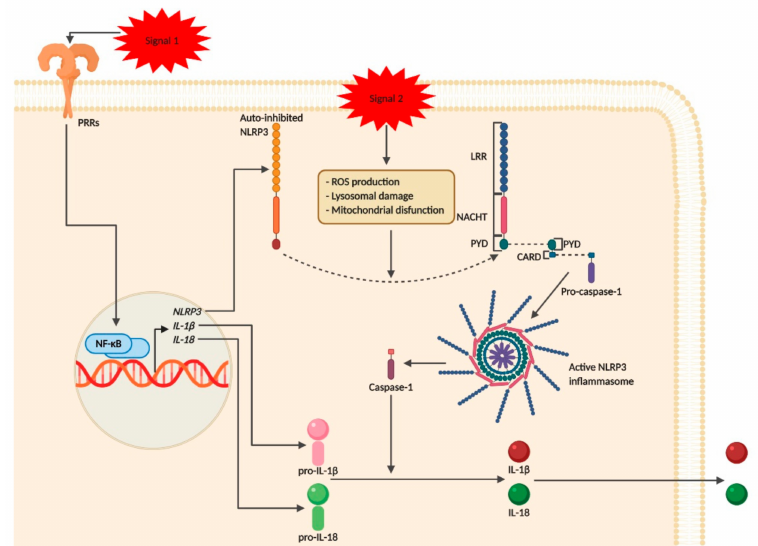
Figure 2. Pyrin domain-containing protein 3 (NLRP3) inflammasome activation. NLRP3 inflammasome is composed of a sensor molecule (e.g., NLRP3), the adaptor protein ASC and the cysteine